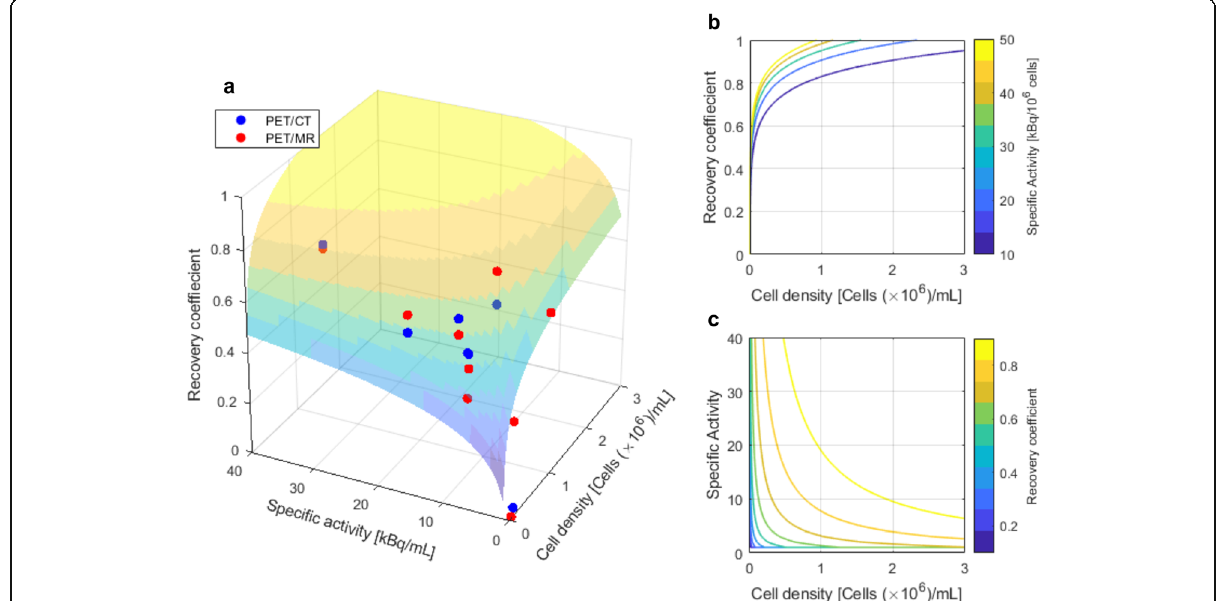
Fig. 7 Recovery coefficient as a function of cell density (10 6 cells/mL) and specific activity (kBq/10 6 cells) for the 3 × 3 cubic-well plate. a Scatter plot of recovery coefficient vs. cell density and specific activity values and corresponding fit surface obtained through a logarithmic model function: y = 0.11 × log(CD × SA) + 0.57; CD = cell density; SA = specific activity. b Contour plot of specific activity as a function of recovery coefficient and cell density. The contours correspond to specific activities ranging from 10 to 50kBq/10 6 cells. c Contour plot of recovery coefficient as a function of specific activity and cell density. Contour lines indicate recovery coefficients ranging from 0.1 to